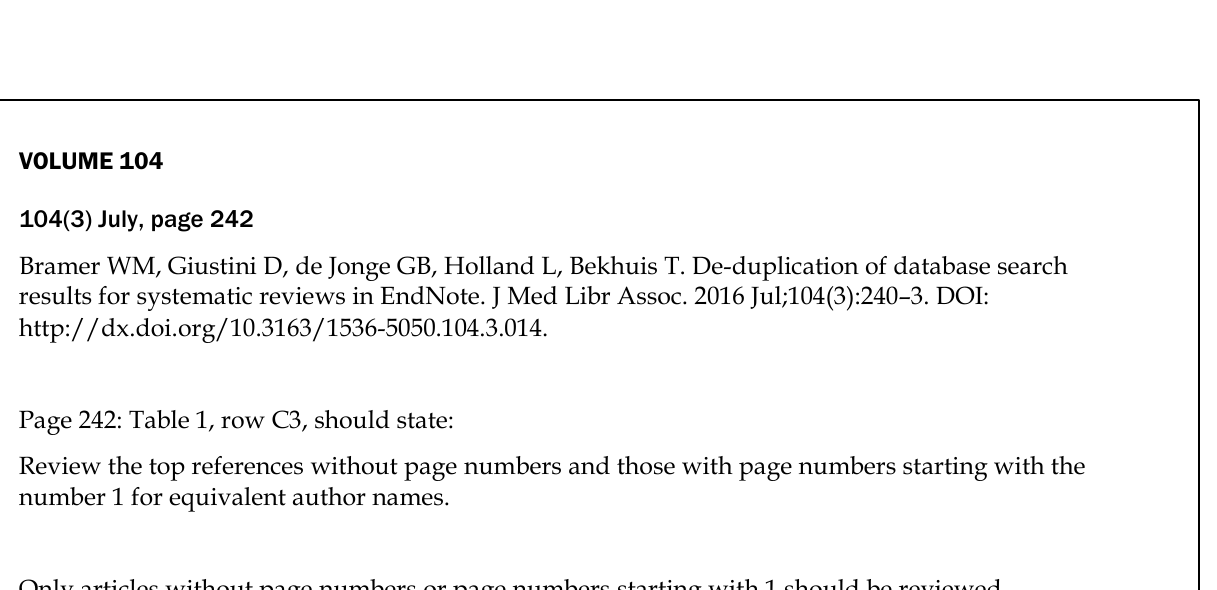
Page 242: Table 1, row C3, should state: Review the top references without page numbers and those with page numbers starting with the number 1 for equivalent author